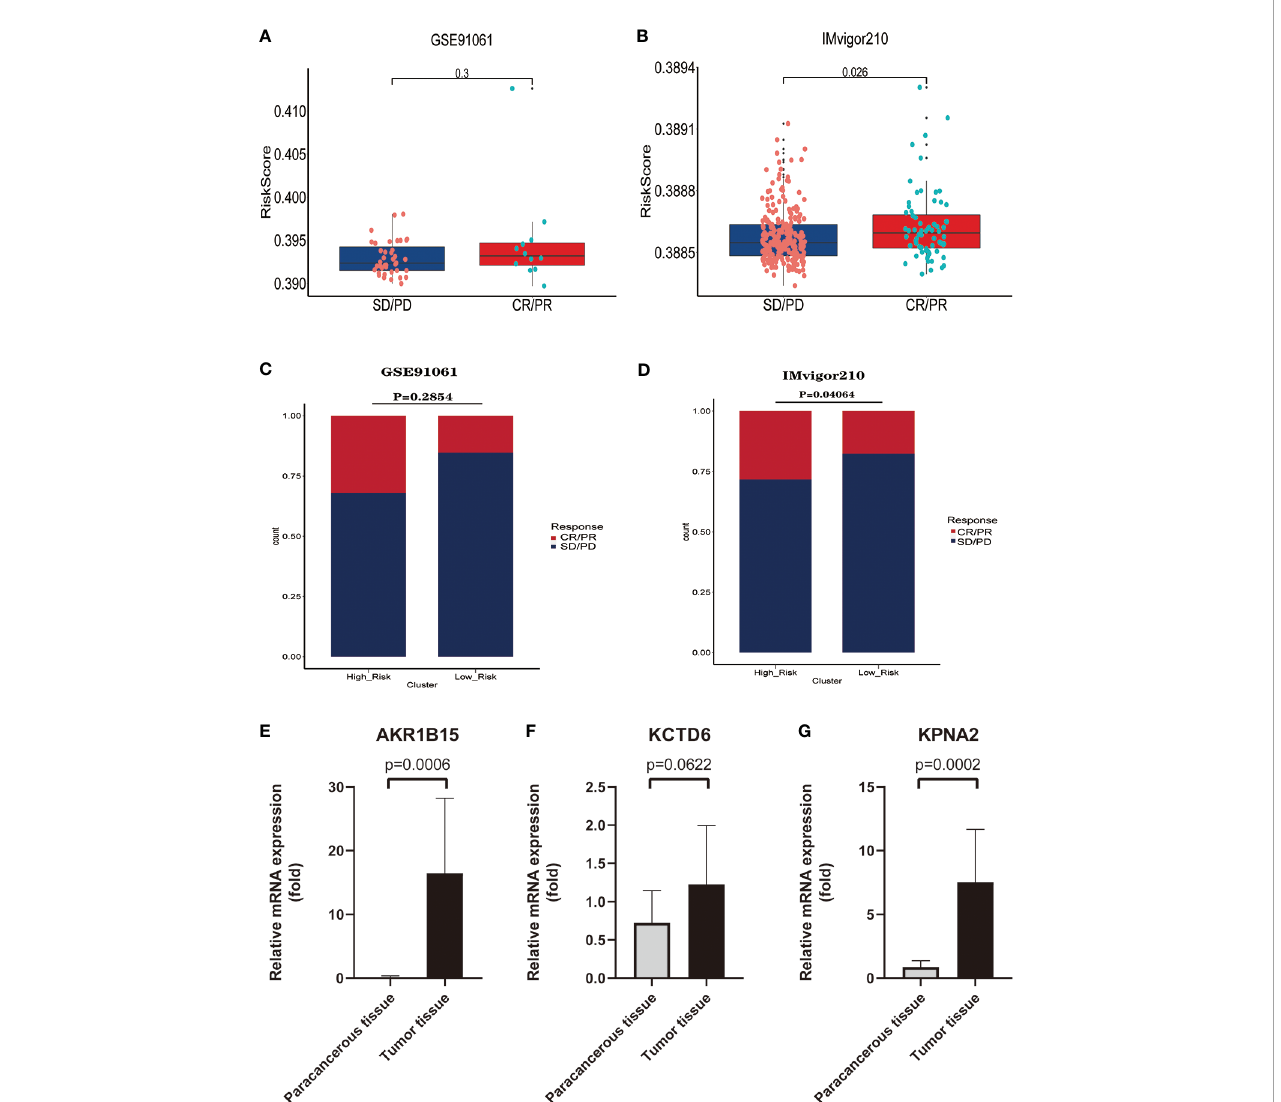
FIGURE 9 Independent external immunotherapy data and RT-qPCR techniques were used to validate the validity and robustness of the prognostic signature. (A) In the GSE91061 dataset, patients who responded to immunotherapy (CR/PR) had a higher median risk score than patients in the low-risk group. (B) In the IMvigor210 dataset, patients who responded to immunotherapy (CR/PR) had signi fi cantly higher risk scores than patients in the low-risk group. (C) In the GSE91061 dataset, the percentage of patients who responded to immunotherapy (CR/PR) was higher in the high-risk group than in the low-risk group. (D) In the IMvigor210 dataset, the percentage of patients who responded to immunotherapy (CR/PR) was signi fi cantly higher in the high-risk group than in the low-risk group. (E-G) qRT-PCR results con fi rmed that the three estrogen-related genes used to construct the prognostic signature were overexpressed in HCC tissues, including AKR1B15 (E) ,KCTD6 (F) and KPNA2 (G)